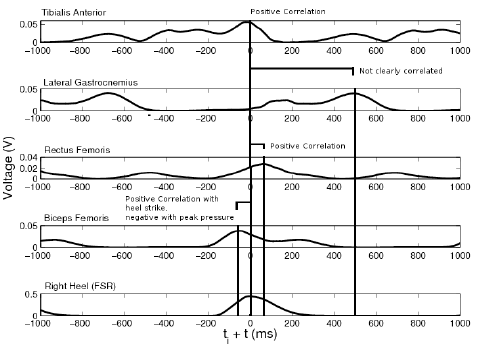
FIGURE 2: Relationship between averaged heel pressure and muscle